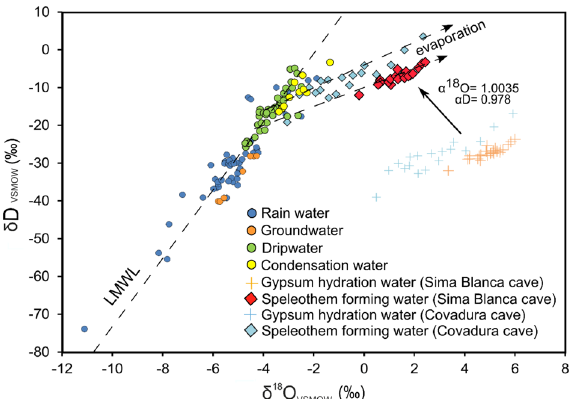
Figure 3. δ 18 O vs δD (V-SMOW) of speleothem-forming waters in Sima Blanca cave, inferred from GHW in the SBL stalactite, after correction with fractionation factors (see main text). Speleothems lie on an evaporation line that intersects the isotopic composition of dripwater (a mixture of infiltration and condensation